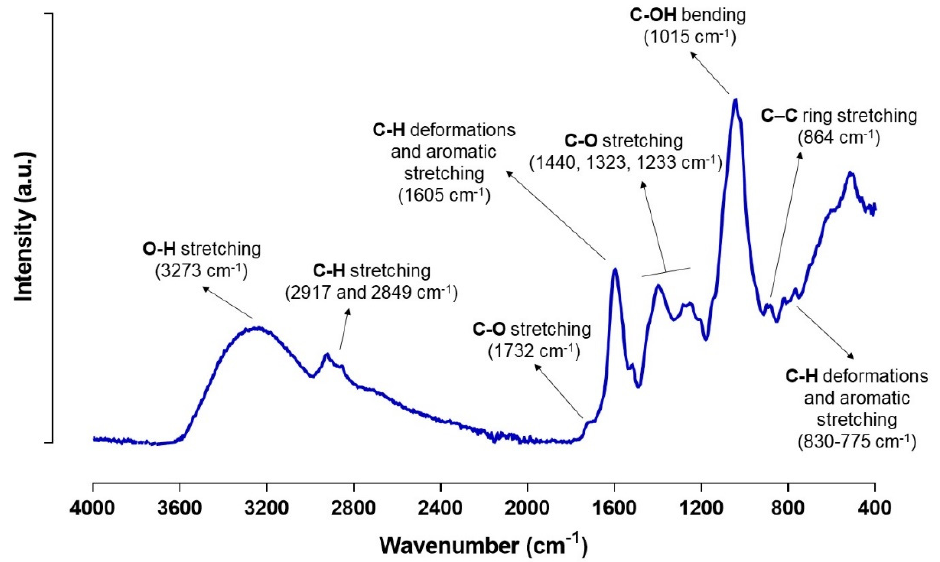
Figure 4. ATR-FTIR spectra of freeze-dried APE.